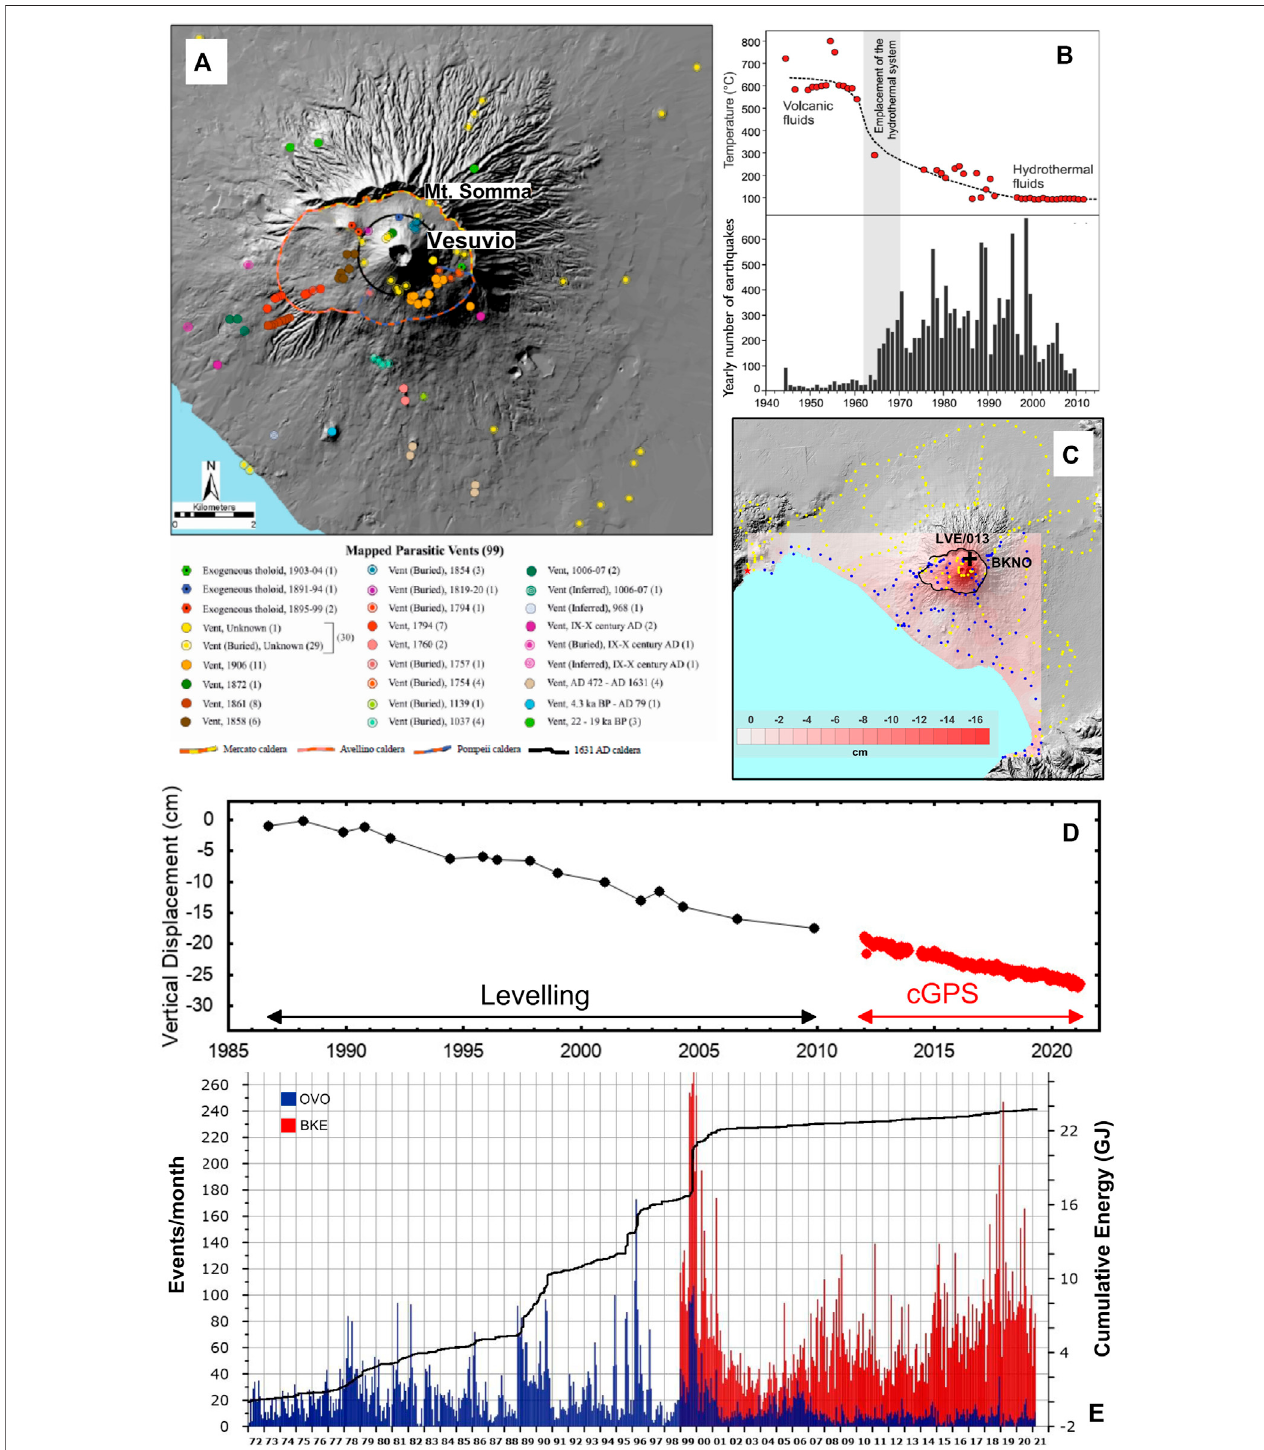
FIGURE6|(A) MapofSomma-Vesuviovolcano,includingthelocationoftheparasiticvents(modi fi edfromTadinietal.,2017). (B) Timebehaviourofthefumaroles temperature andnumber ofearthquakesperyearsince1944(modi fi edfromDelPezzoetal.,2013). (C) Map oftheverticaldisplacement fi eldfortheperiod 2000 – 2009. Thelevellingbenchmarkscommontothetwosurveysareshowninblue(modi fi edfromFolcoPingueetal.,2013). (D) ElevationchangesofbenchmarkLVE/013(location inc)from1986to2010(afterFolcoPingueetal.,2013)mergedwithmorerecent(2012 – 2020)verticaldisplacementatthecontinuousGPSstationBKNO(location in c). (E) Number of earthquakes per month since 1972 recorded at stations OVO (Vesuvian Observatory; about 2.5 km WNW from the crater) and BKE (located about 1 kmESE fromthecrater); notethat:i)after2006theseismicity,being concentratedintheveryshallow partofthecraterarea,hasbeen characterizedbylowmagnitude and cumulative energy released (continuous black line; referred to OVO station).